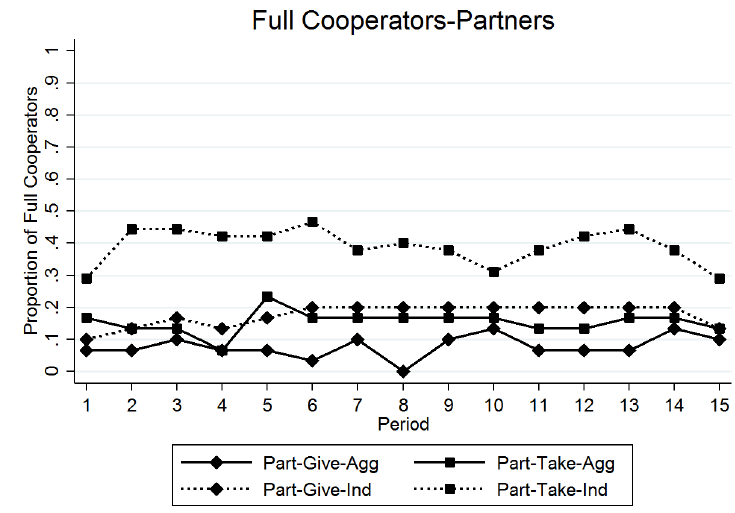
Figure 3. Proportion of Full Cooperators Over Time